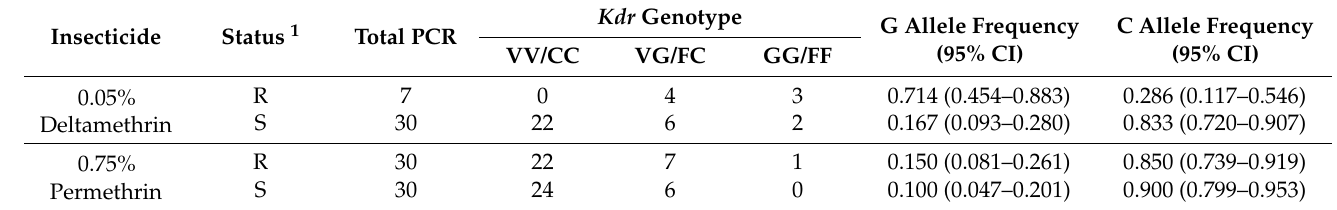
Table 3. Genotype and allele frequencies of the V1016G, F1534C kdr mutations in F1 Ae. aegypti from Suan Oi village. Table 4. Association between V1016G and F1534C alleles with resistance phenotype to deltamethrin and permethrin in adult Ae. aegypti